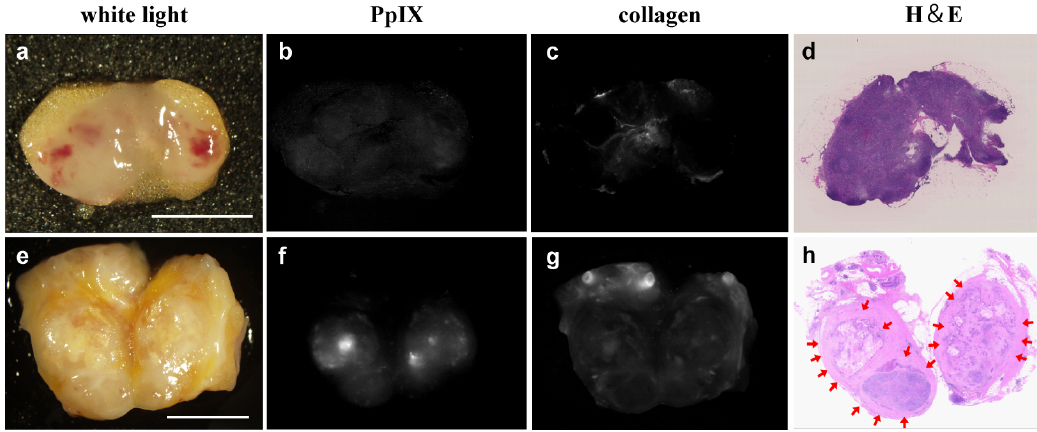
Figure 2. Imaging of a metastatic and a non-metastatic lymph node (LN) by using spectral unmixing. Images of a non-metastatic LN ( a – d ) and a metastatic LN ( e – h ) cut in half are shown; ( a , e ) White-light images; ( b , f ) Spectral unmixed fluorescent signal of PpIX; ( c , g ) Spectral unmixed fluorescent signal of collagen; ( d , h ) H & E-stained images. Red arrows indicate metastatic lesions. Scale bar = 5 mm.